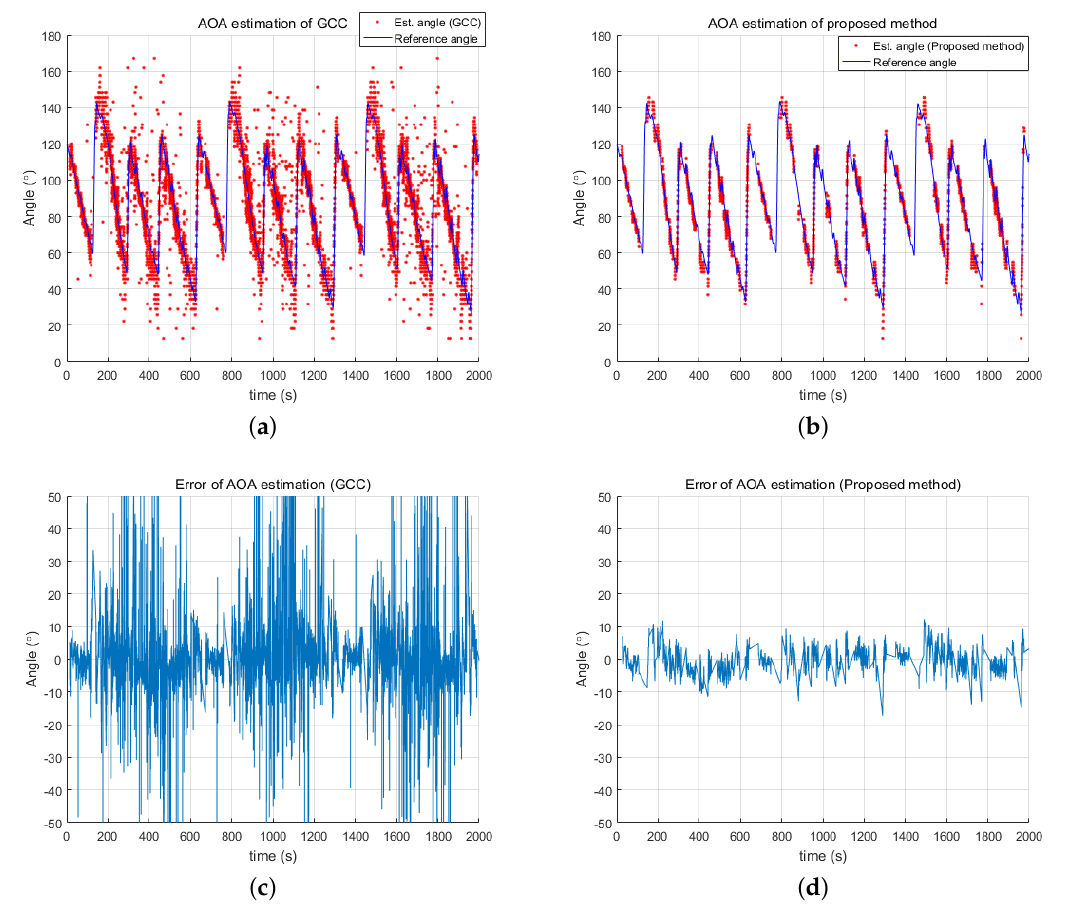
Figure 6. Error of estimated directional angles: ( a ) reference angle and estimated angle from GCC; ( b ) reference angle and estimated angle from the proposed method; ( c ) error of GCC-estimated angle; and ( d ) error of estimate from the proposed